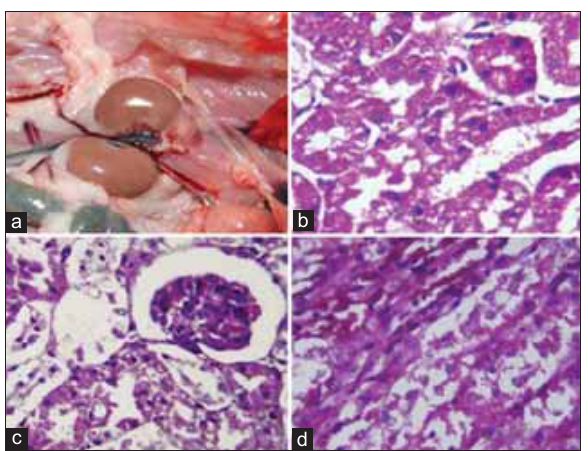
Figure-4: (a) Depletion of lymphocytes in the periarteriolar lymphoid sheath and marginal zone in white pulp in spleen from rats of 25 mg/kg group, (b and c) Spleen of rats 100 mg/kg group showed severe depletion of lymphocytes from malpighian corpuscles and hemorrhages, (d) In spleen of rats of 200 mg/kg group showing severe depletion of lymphocytes from the malphigian corpuscle.